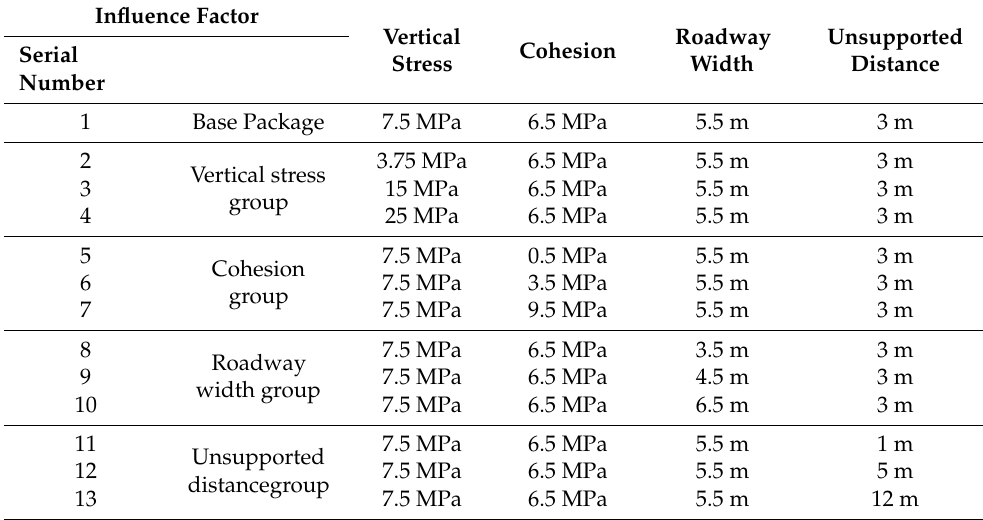
Table 3. Roof and floor strata relative to simulated entry and mechanical parameters. Influence Factor Vertical